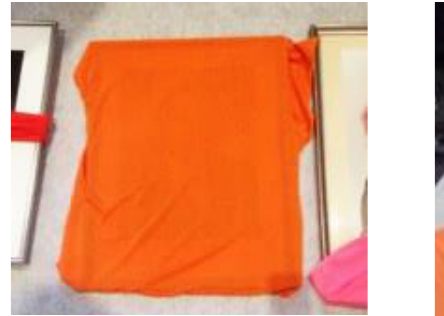
Figure 4 : A wrapped photo Figure 5 : Photo